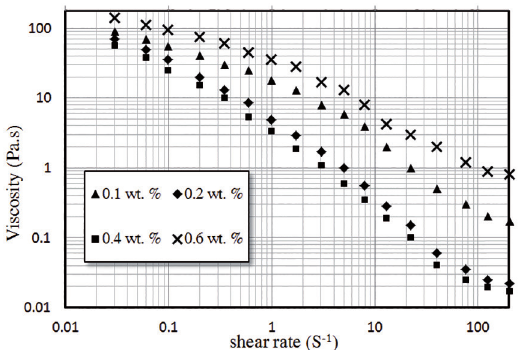
Figure 5: The effect of dispersant concentrations on the viscosity of premix solutions containing 50 vol. %